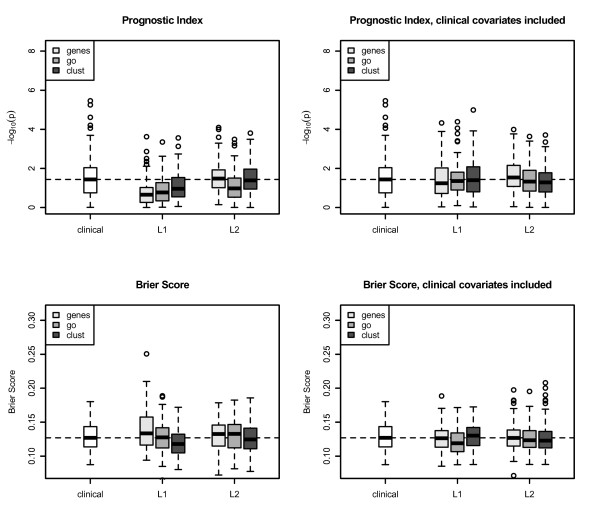
Results: Mainz cohort study. The boxplots show results for lasso and ridge regression applied to 100 training/test splits for genes, GO groups, and preclustered GO groups for the Mainz cohort study. P-values of the prognostic index are presented on - log10 scale. A small value of a criterion corresponds to a good prediction performance. The Brier Scores are calculated for 10 years follow-up. Small values of the Integrated Brier Score correspond to good prediction performance. L1= ^lassoregression,L2= ^ridgeregression.